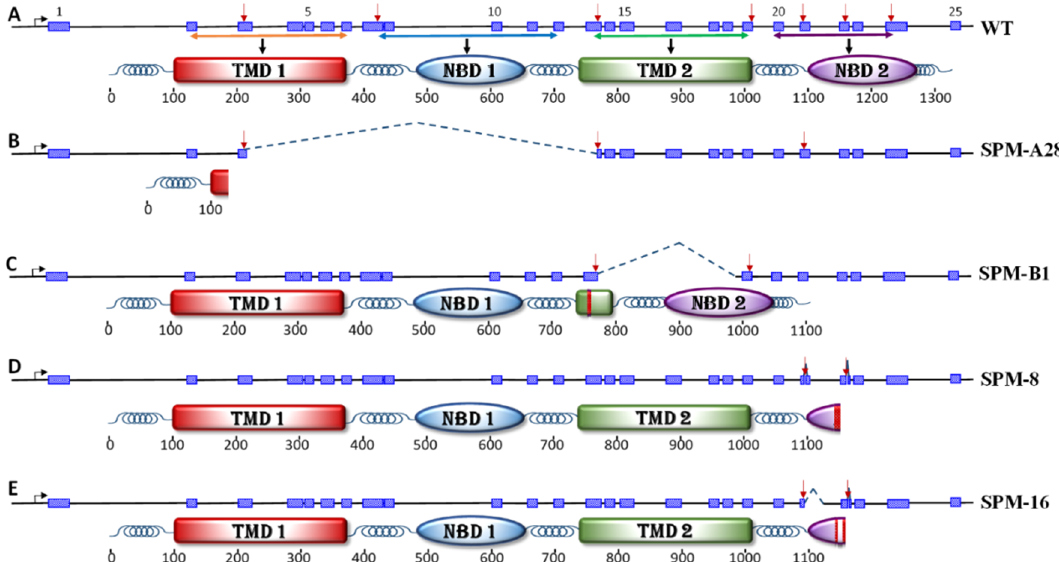
Figure 1. Organization of Helicoverpa zea ATP binding cassette transporter subfamily C2 ( ABCC2 ) transporter gene and CRISPR/Cas9 mediated deletions generated and tested in this study. Exons and introns, spaced to scale, are shown by blue hatched rectangles and solid black lines, respectively. Numbers below the predicted polypeptide represent amino acids. ( A ). Wild type ABCC2 gene containing 25 exons and predicted polypeptide with transmembrane (TMD) and nucleotide- binding (NBD) domains. Exons 1, 5, 10, 15, 20, and 25 are numbered above the gene diagram. Approximate location of the promoter and exons coding for TMD 1, TMD 2, NBD 1, and NBD 2 are shown by horizontal double arrows. Locations for target sites in exons 3, 8, 13, 19, 21, 22, and 24 for which single guide RNA (sgRNA) were designed are shown with red down arrows. ( B ) . Knockout line SPM-A28C generated by sgRNA targeting exons 3 and 13 which truncated the ABCC2 protein at amino acid 127. ( C ). Knockout line SPM-B1 with a deletion from exon 13 to 19 recovered from the experiment targeting exons 13, 19, and 21 in a polypeptide that had a deletion of 255 amino acids at the beginning of the TMD 2 (starting at amino acid 760). Alternative splicing using a splice donor (GT) site in exon 13 to exon 19 restored the NBD2 domain of the ABCC2 protein. ( D , E ) . Knockouts generated by sgRNA targeting exons 21, 22, and 24. In SPM-8 ( D ), a 7 bp deletion in exon 21 (from 93,539 to 93,545 bp in genomic scaffold) truncated the polypeptide at amino acid 1122 and added eight random amino acids, inactivating NBD2. In knockout line SPM-16 ( E ), a deletion of 426 bp from 93,540 to 93,965 (exon 21 to intron 21) created an open reading frame and extended the truncated NBD2 polypeptide sequence with 34 random amino acids. In this knockout line there was an additional 4 bp insertion at the exon 22 sgRNA target site (position 94,196 bp of the genomic scaffold) that did not affect the outcome due to truncation of the protein by the deletion in exon 21. Red arrows in ( B – E ) indicate the position of sgRNA that caused the mutation in each line.